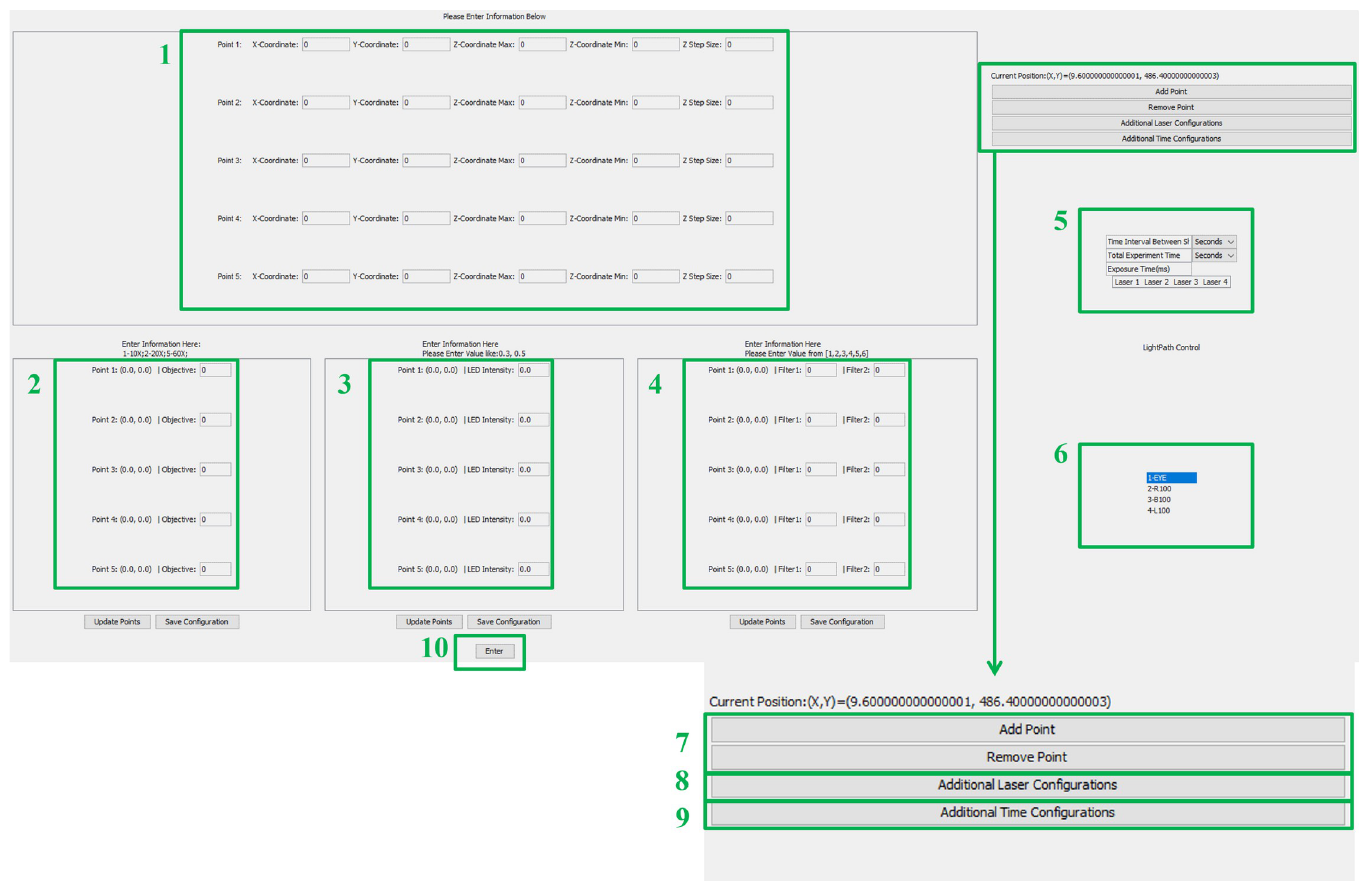
Fig 2. The graphical user interface (GUI) of AMFIP. The all-in-one GUI of AMFIP enables users to program all experimental parameters and essential functions according to users’ specific experimental requirements and environment. Users are allowed to (1) Input X, Y, Z coordinates for each FOV; (2) Specify the types of microscope objective for each FOV; (3) Specify the intensity of DiaLamp for each FOV; (4) Specify desired filter cubes for each FOV; (5) Define the universal time and laser configurations for each FOV in the experiment; (6) Switch to different light path; (7) Add or remove points; (8) Open up the window for additional laser configuration; (9) Open up the window for additional time configuration; and (10) Start the specified experimental procedure.